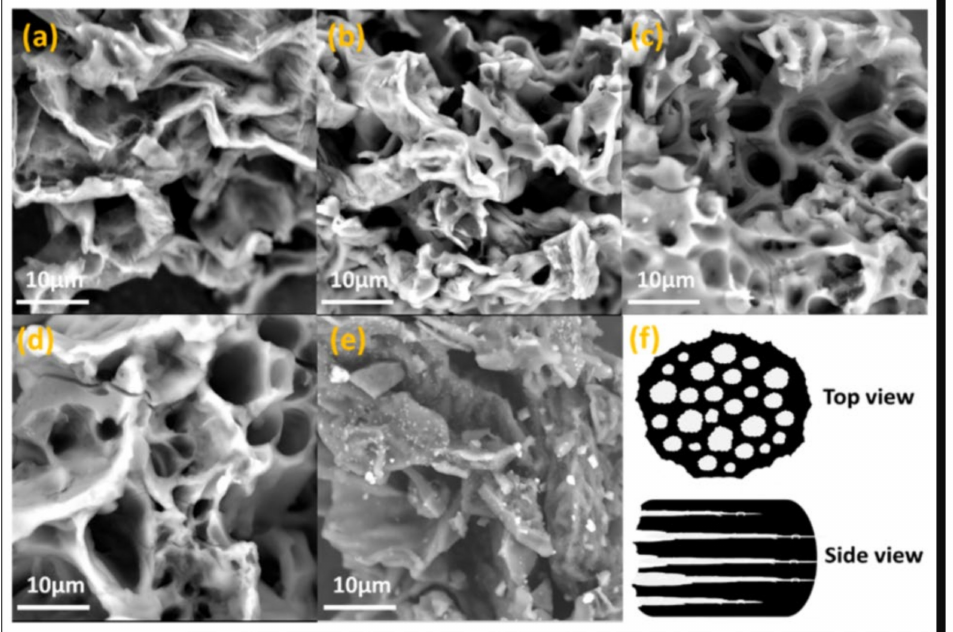
Figure 13. SEM images of ( a ) OPAC-0.5, ( b ) OPAC-1, ( c ) OPAC-2, ( d ) OPAC-3, ( e ) OPUAC, ( f ) schematic diagram of the porous structure in carbon derived from OP. Adapted with permission from Ref. [116].